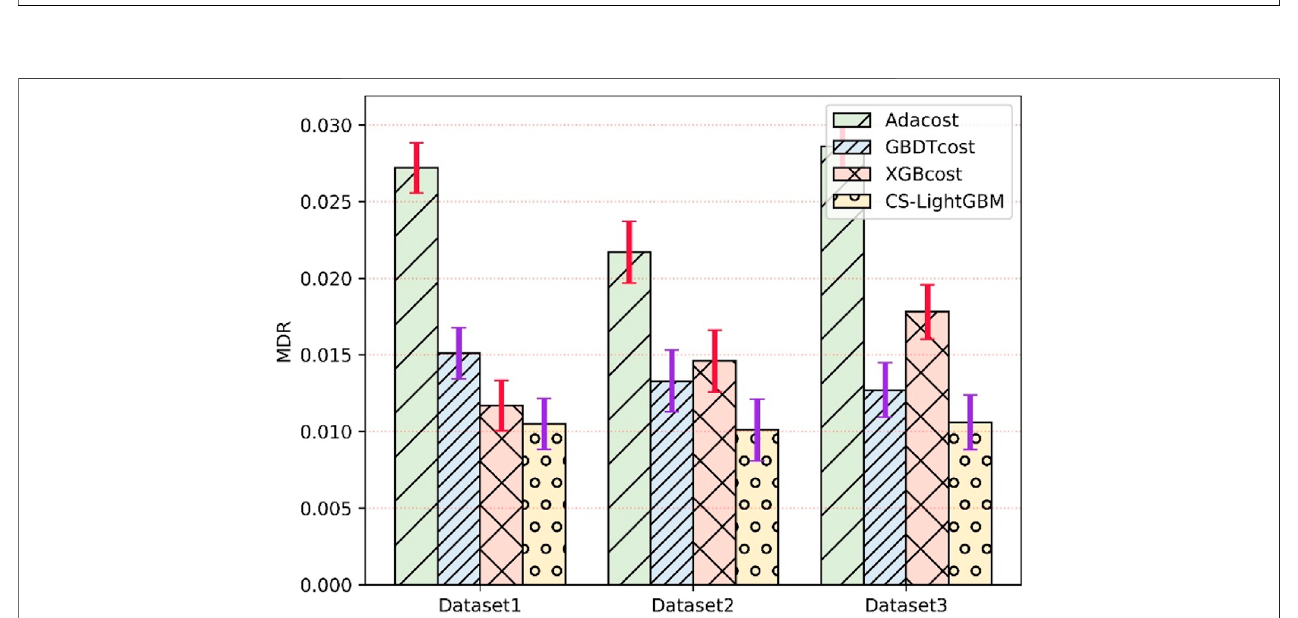
FIGURE 6 | Missing detection rate of four algorithms for fault detection of wind turbines gearboxes.